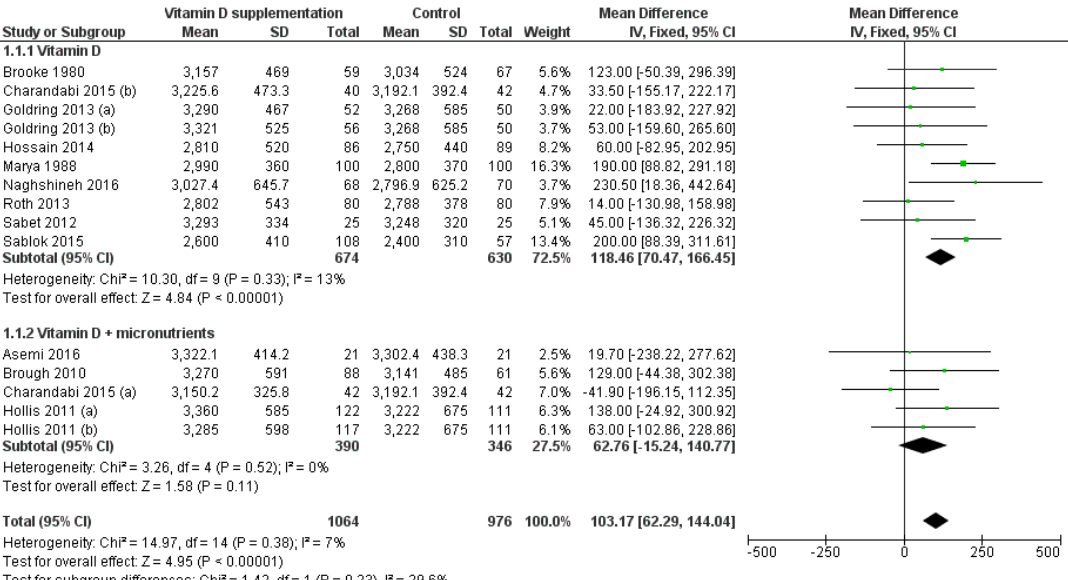
Figure 2. Forest plot of the effect of vitamin D intervention alone or in combination with micronutrients on birthweight (g), based on the fixed-effects model. Charandabi 2015 ( a ): Vit D +